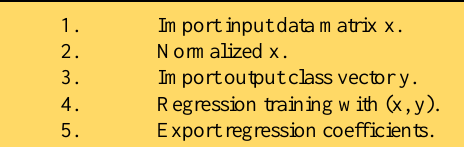
Figure 6. The pseudo-code required for calculate regression coefficients.